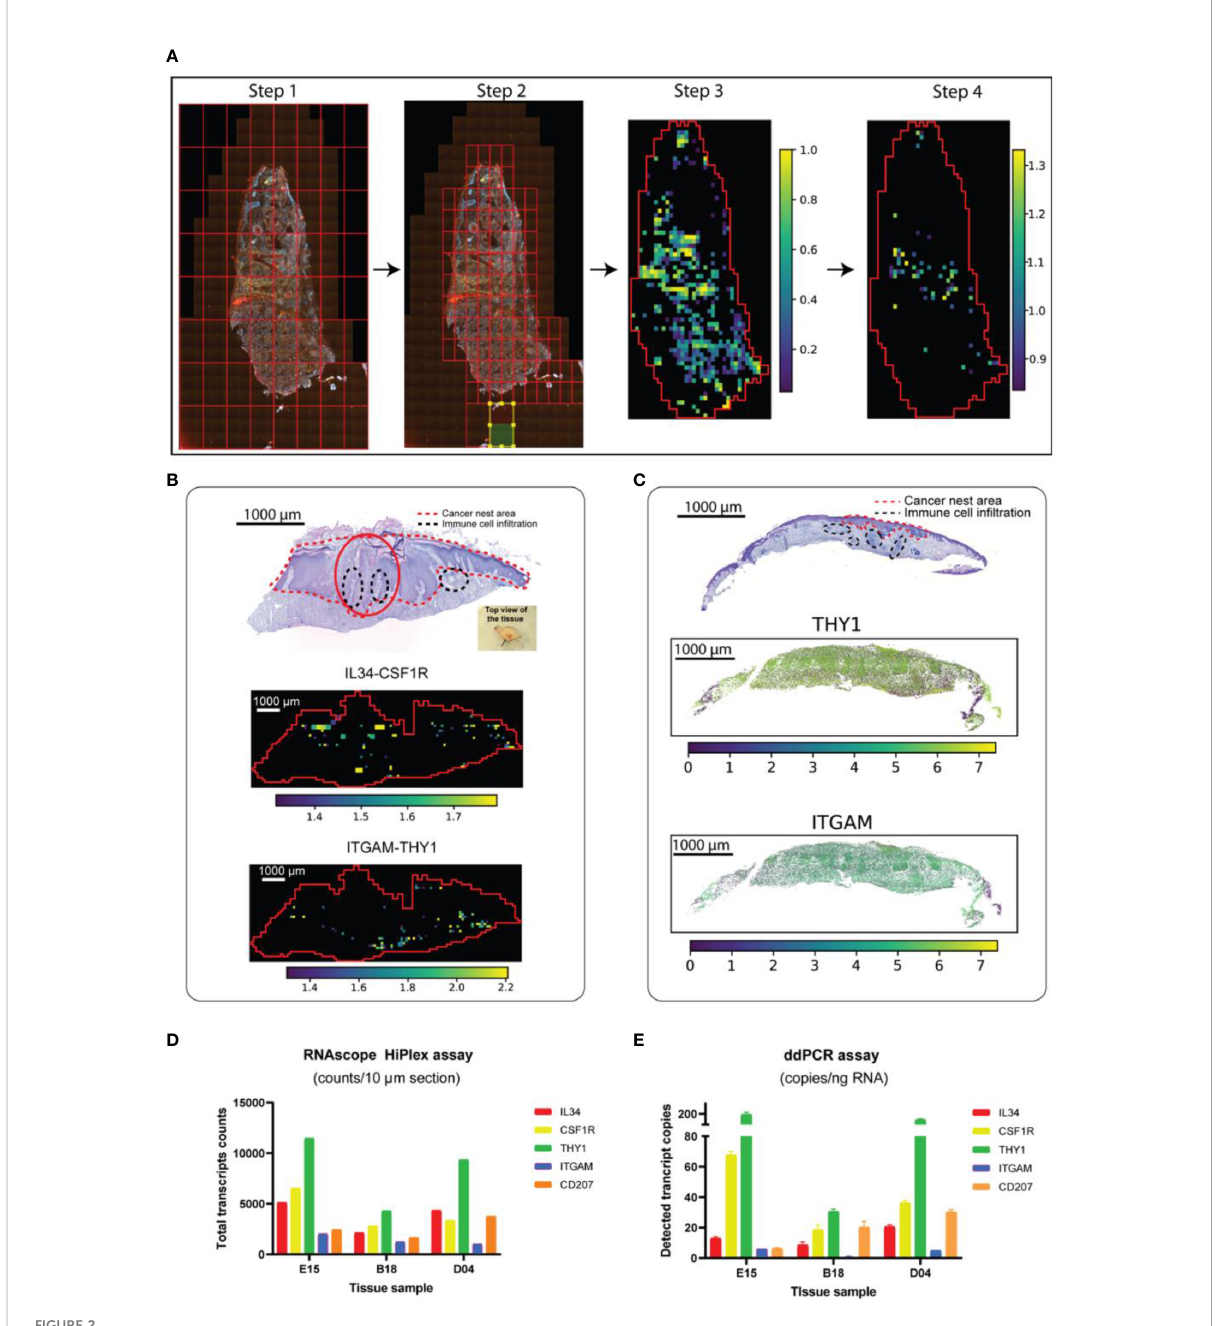
FIGURE 2 Detection of target RNAs in skin cancer patients by collective transcriptomic and genomic methods. (A) STRISH analysis method to scan for local- coexpression of ligan-receptor pairs. Steps from raw RNAscope data to creating a tissue-scale heatmap (signi fi cant activity map) of local co-expression of target mRNAs are shown. Brie fl y, STRISH splits the image into large, even-sized windows (Step 1). Based on cell segmentation and the count of number of cells per window, STRISH further splits a window into smaller ones if the window has more cells than required and discards those windows without cells (Step 2). Using the remaining windows which contains cells expressing L-R, STRISH can perform the co-localization scoring and statistical test to produce a heatmap of the most signi fi cant windows in spatial context (Step 3 and 4). (B) From top to bottom: annotated H&E of SCC patient ID- F21 and the corresponding heatmaps (activity maps) of local co-expression for the two L-R pairs, IL34-CSF1R and THY1-ITGAM, respectively. (C) The expression levels of THY1 and ITGAM using RNAscope signal measurement within the cells throughout the tissue of the patient ID-D04. (D, E) The absolute copy number of the target mRNAs counted using ddPCR and RNAscope